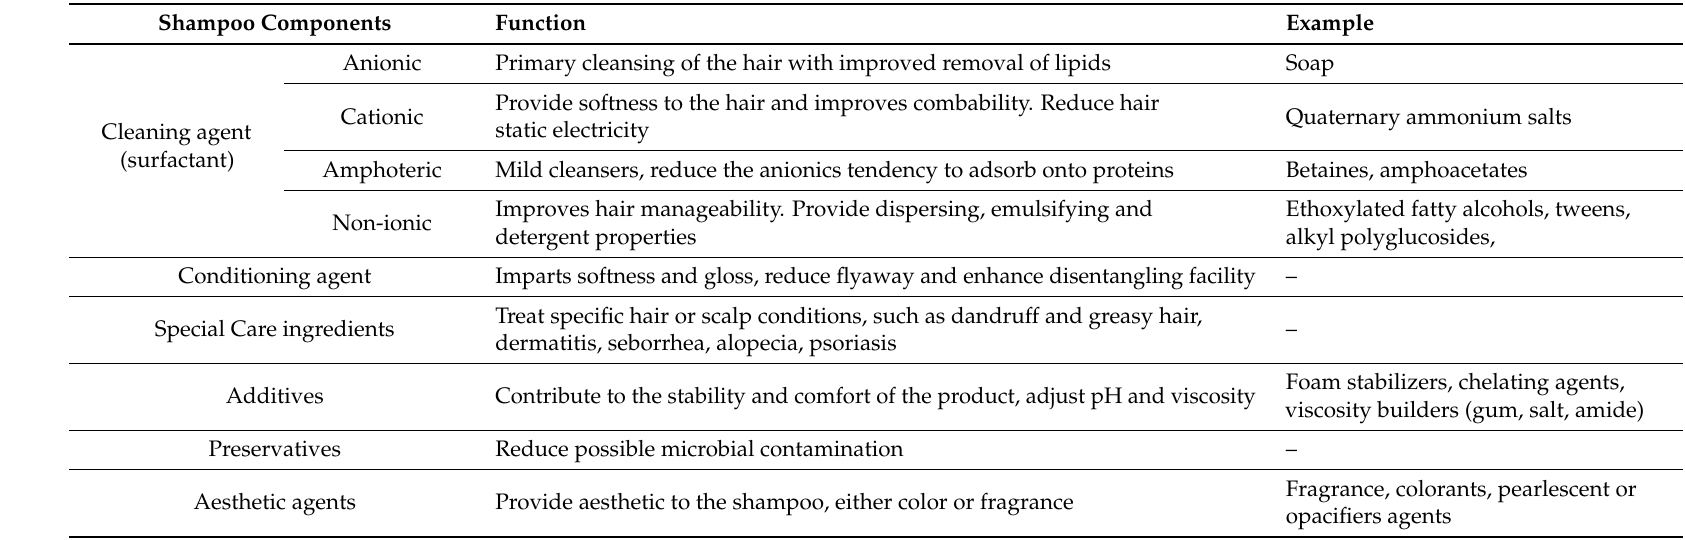
Table 1. Shampoo formulation components